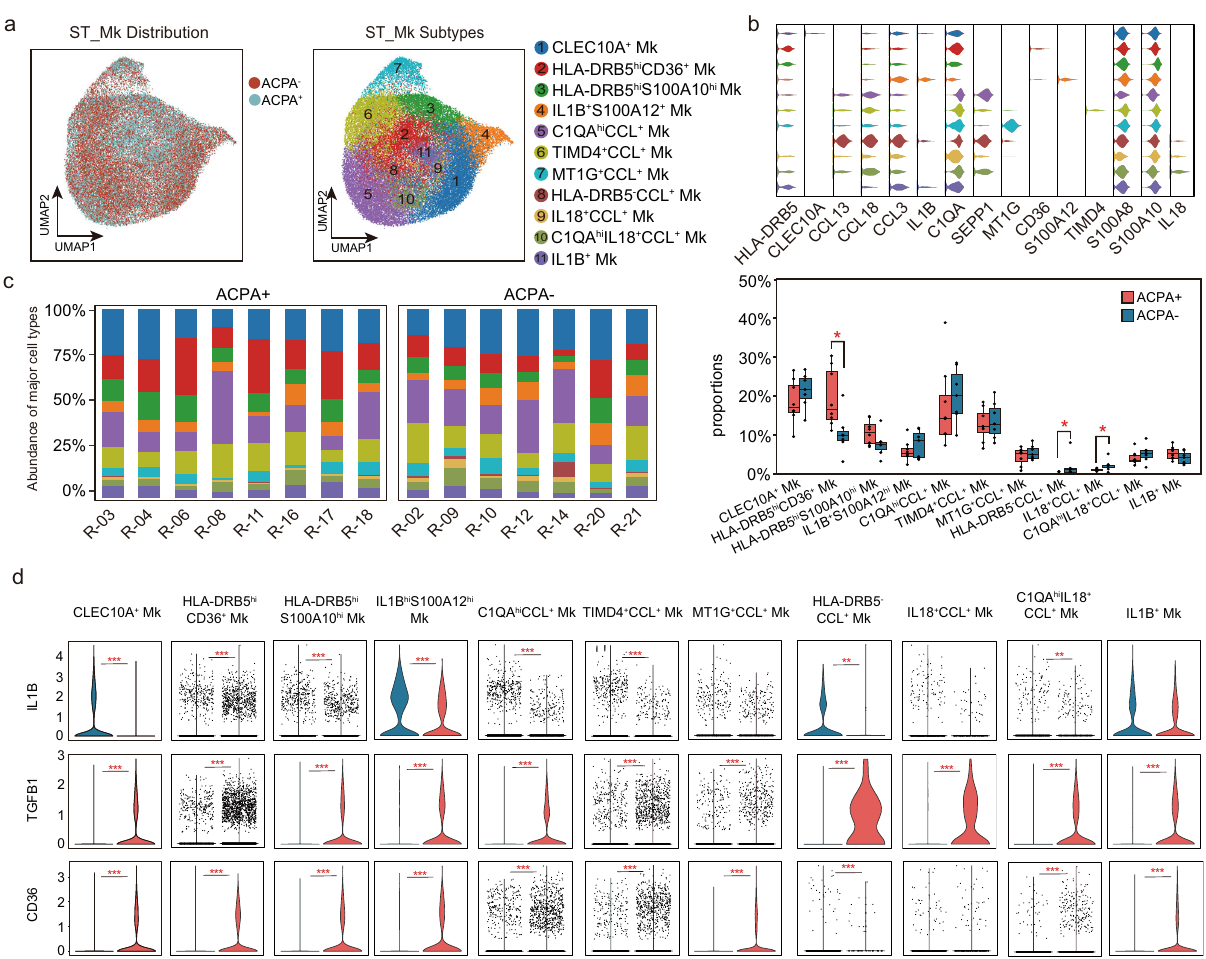
Fig. 5 Identi fi cation of macrophage subsets in the synovium of patients with RA. a UMAP visualization of macrophages from the synovium. Among 46,973 cells, we identi fi ed 11 macrophage subtypes. Cells are marked by ACPA type(left) and cell subtypes (right). b Violin plots showing marker genes across cell subtypes in A. The y axis represents log-scaled normalized counts. c Left: Bar plots showing the relative percentage of STMC macrophage subtypes for each sample as in a. Right: Box plots showing the proportions of each STMC macrophage subtypes across ACPA groups. Cell types showed enrichment in ACPA + or ACPA- subgroups are marked with * P values were calculated by the two-sided Wilcoxon test. * p < 0.05 (from left to right, p = 0.021, 0.043), ** p < 0.01 ( p = 0.0093). n = 10 for ACPA + group, and n = 10 for ACPA- group. d Violin plots showing the differences in the expression of IL1B, TGFB1, and CD36 between ACPA- and ACPA + macrophage subtypes in STMC. Asterisks indicate the signi fi cance. P values were calculated by the two-sided Wilcoxon test. * p < 0.05, ** p < 0.01, *** p < (Fig. 5b). IL1B + S100A12 + macrophages and IL1B + macrophages